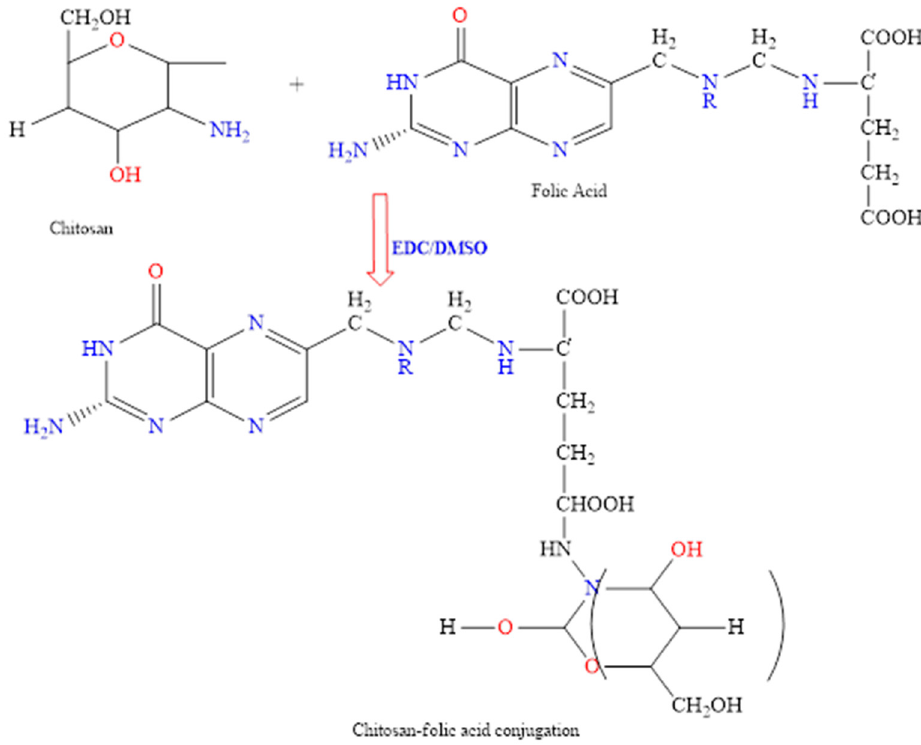
Figure 1. A scheme illustrating the reaction of chitosan with folic